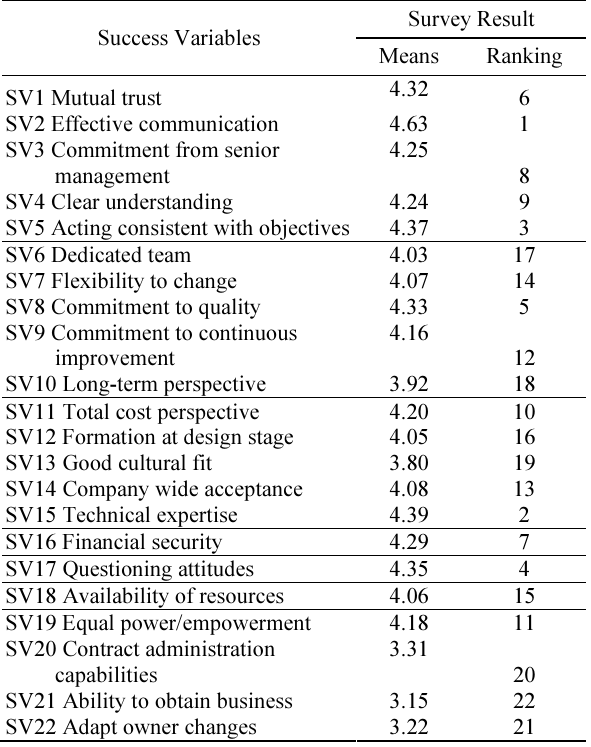
Table 1. The 22 nominated SVs in construction partnership